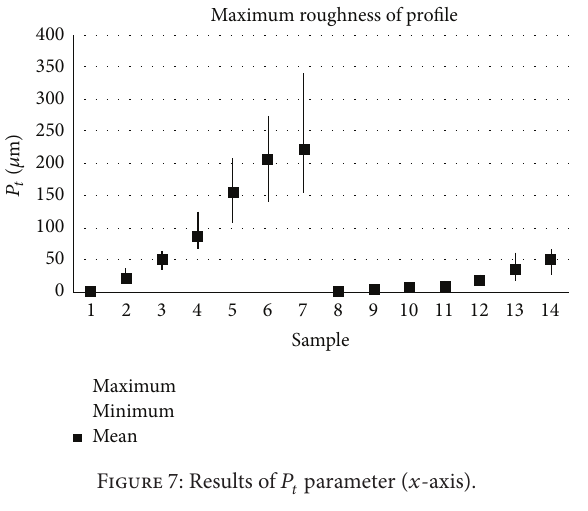
Figure 10: Results of fractal dimension estimation, 𝐷 𝐶1000 ( 𝑥 -axis).